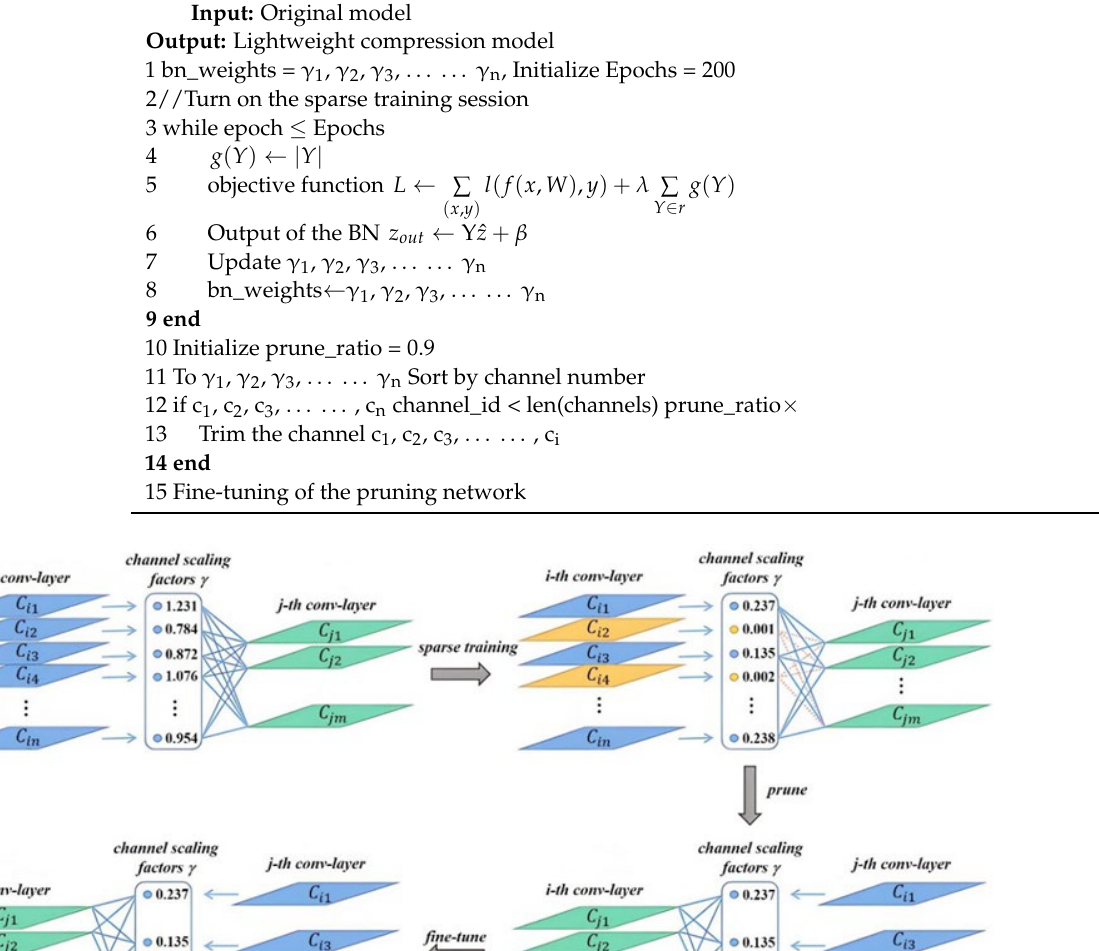
Algorithm 1 A channel pruning algorithm based on the scaling factor